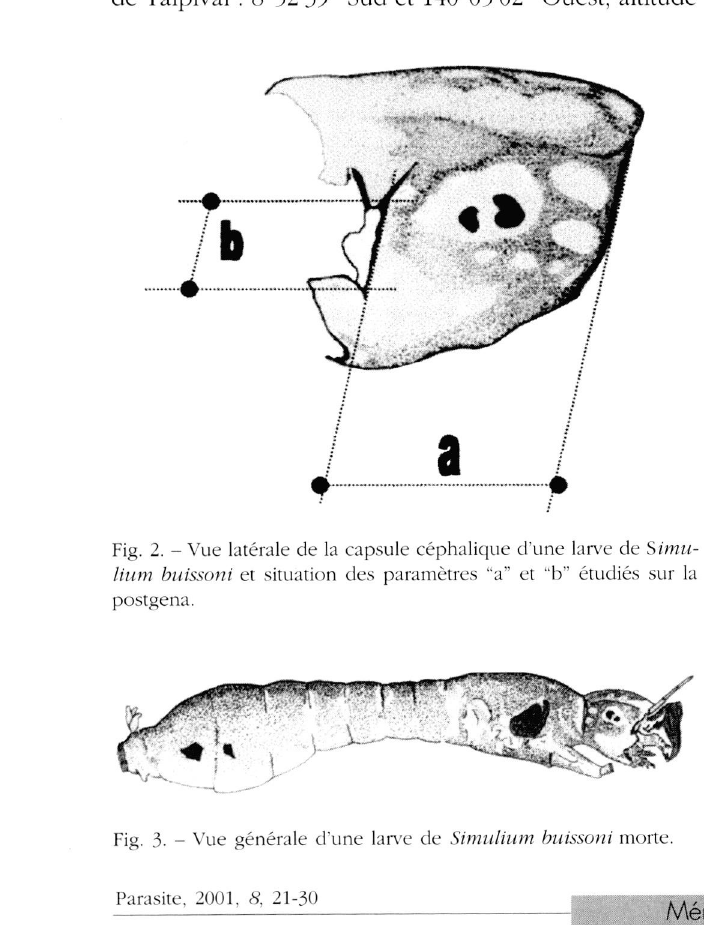
Fig. 3. - Vue générale d'une larve de Simulium buissoni morte. Parasite, 2001, 8,